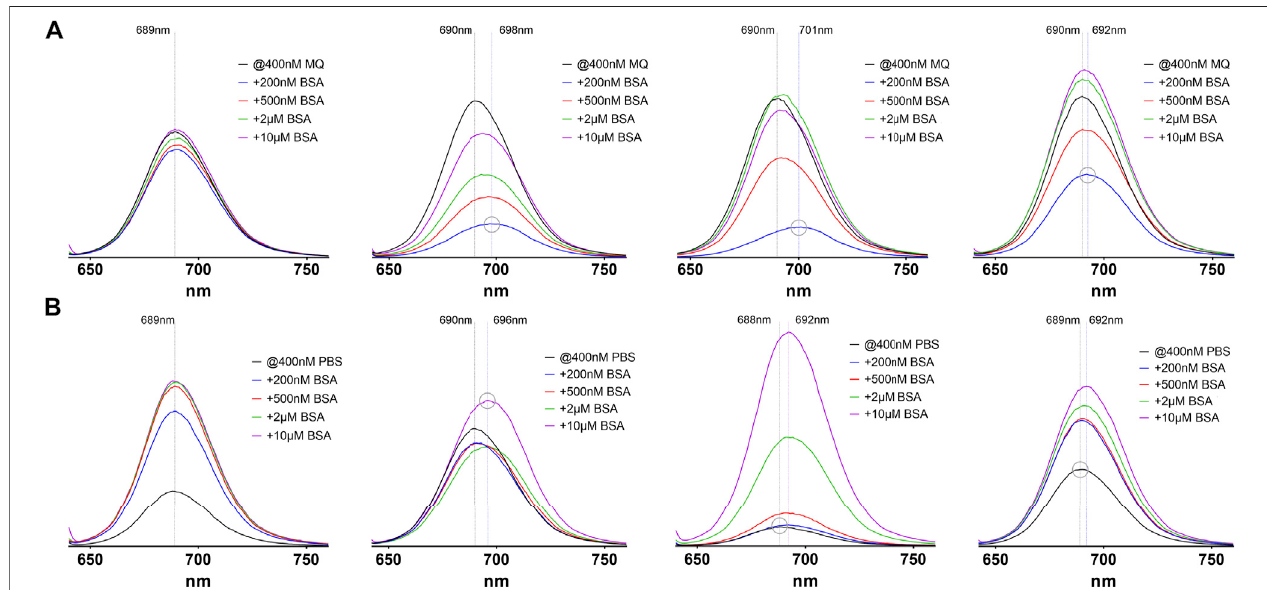
FIGURE 4 | Emission spectra of the four investigated probes 2 – 5 (from left to right) in pure water (A) and PBS (B) . In each image the black line represents the absorption without addition of BSA, where every compound shows a maximum emission around 689 nm, regardless of the solvent used. The y-axis scale is identical in all images. The dashed lines depict the emission maximum wavelengths without and with BSA (maximum red-shift). The grey circle stresses peaks with the highest or lowest emission maximum wavelength to illustrate the observed red-shifts.